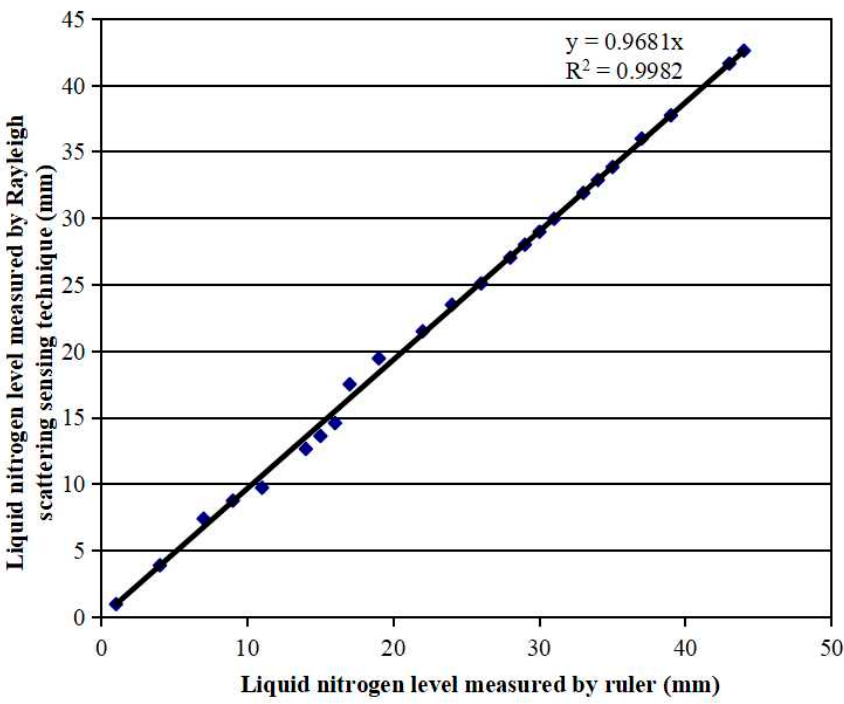
Figure 4. Comparison of the liquid nitrogen level measured by the fiber sensor and the ruler.